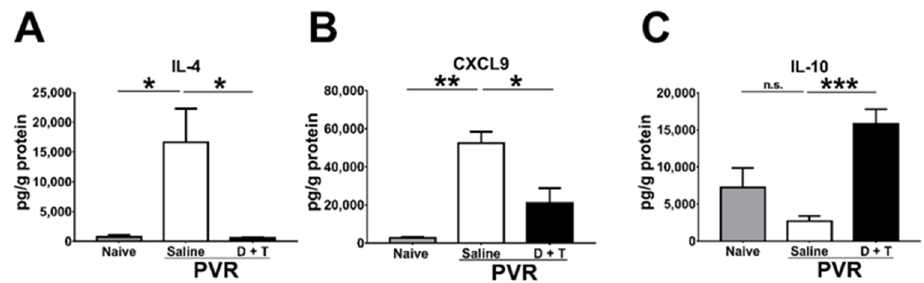
Figure 6. The effects of doxycycline and tetracycline treatment on cytokine and chemokine levels in the retina samples of mice after PVR induction. The retinas harvested from naïve mice or mice with PVR induction and treated with saline or doxycycline plus tetracycline (D + T) were subjected to the Luminex assay to determine the levels of ( A ) IL-4, ( B ) CXCL9, and ( C ) IL-10 21 days after PVR induction. The data represent means + SEM (error bars) of ≥3 samples per group. Note: *, p < 0.05, **, p < 0.01, and ***, p < 0.001 via Student’s t test; n.s.: not significant.